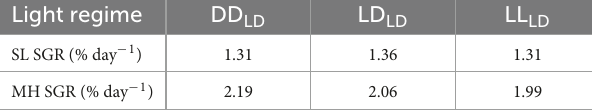
TABLE 2 Morphometric changes in first-feeding Atlantic salmon from 830 to 991-day degrees (dd) (14 days in between samplings). Light